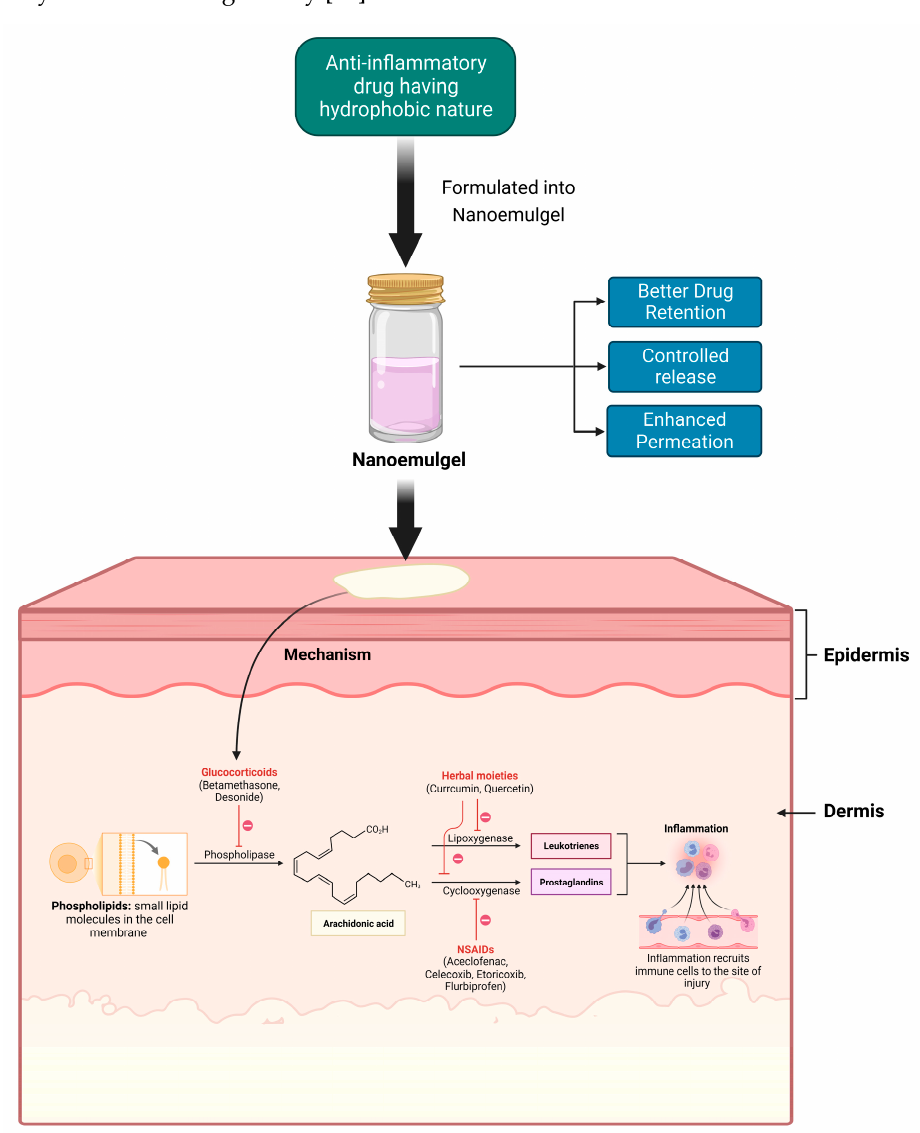
Figure 1. Delivery of anti-in fl ammatory drug along with its mechanism of action.